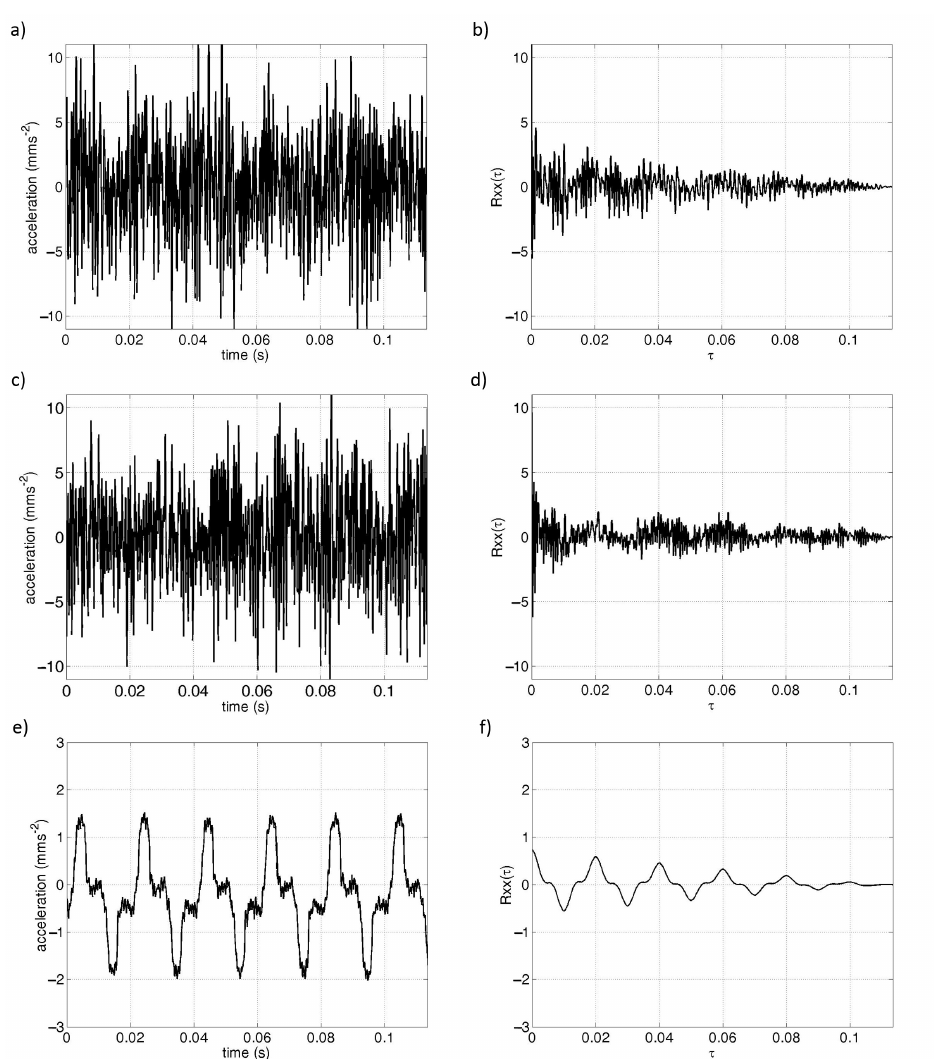
Figure 6. Time waveforms of the measured signals during the operation of the pair of aggregates in the operating modes IV.–VI. (( a ) motor and pump vibration signal time waveform, ( b ) motor and pump auto-correlation function, ( c ) motor and hydro-generator vibration signal time waveform, ( d ) motor and hydro-generator vibration auto-correlation function, ( e ) pump and hydro-generator vibration signal time waveform, ( f ) autocorrelation function of pump and